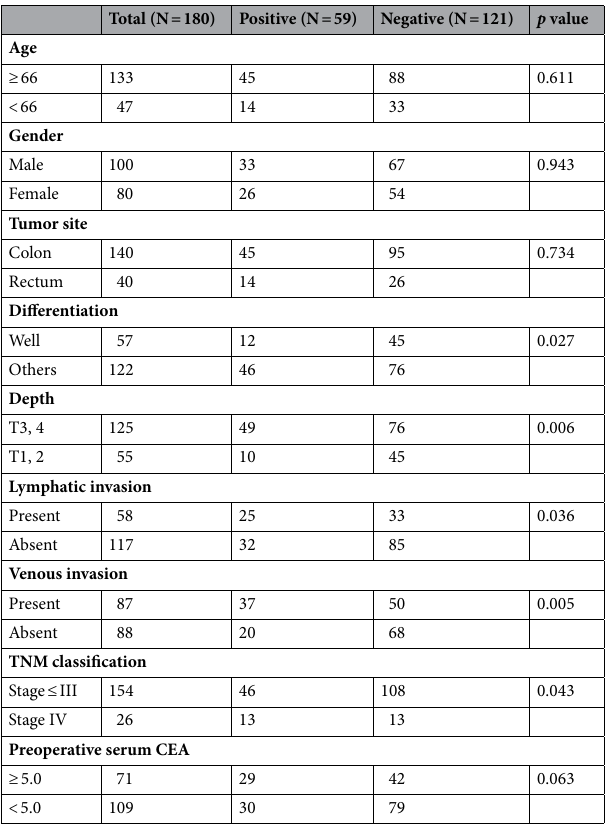
Table 1. Clinicopathologic variables for KRAS status in ctDNA. Well well differentiated adenocarcinoma; others moderately differentiated, poorly differentiated, mucinous and papillary